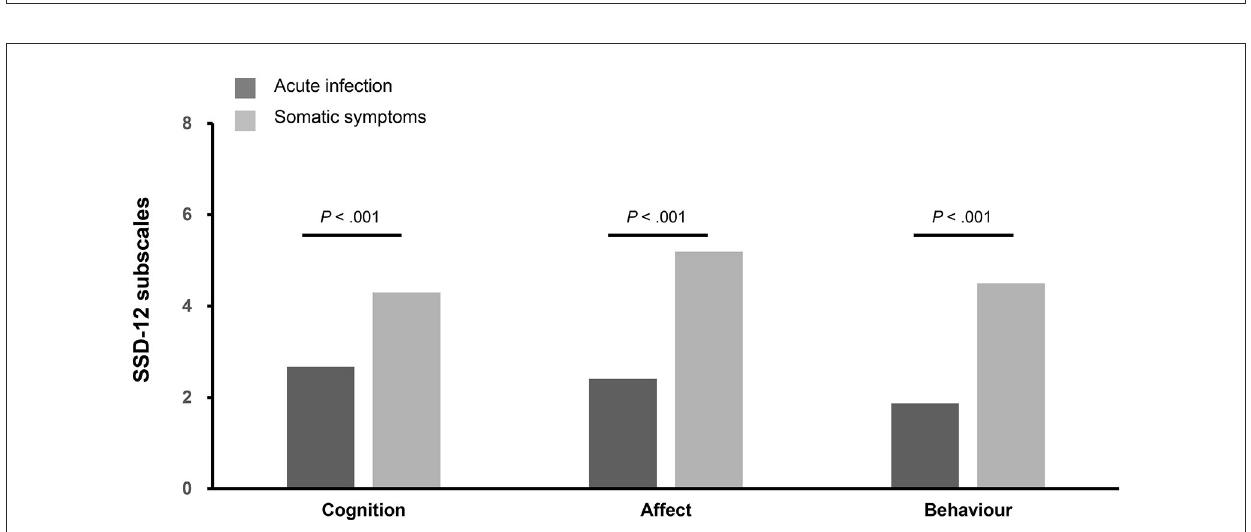
FIGURE3 Comparison of the three SSD-12 subscales. The figure shows the different subdimensions (0 = not at all, 4 = very strongly) of the Somatic Symptom Disorder-12 (SSD-12) questionnaire stratified for participants of the acute infection group ( n = 138) and participants of the somatic symptom group ( n =